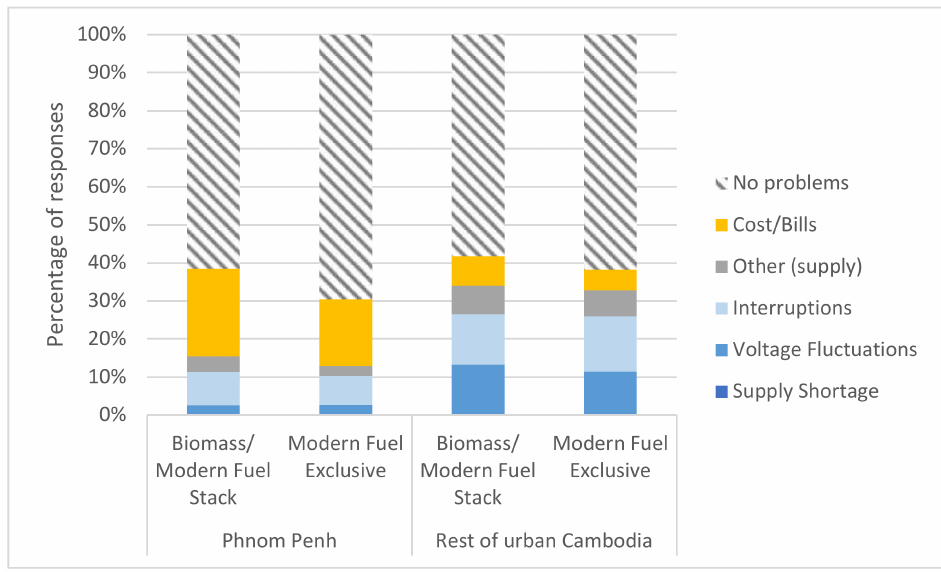
Figure 3. The main problems with a household’s electricity supply, Cambodia (up to two responses per household).